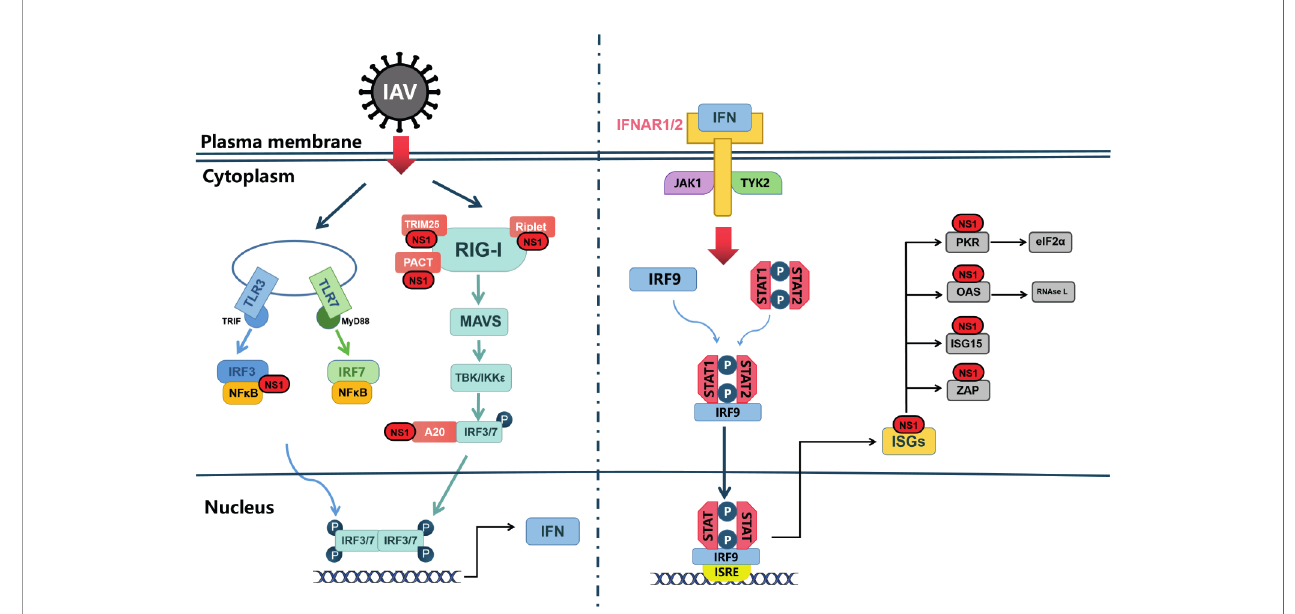
FIGURE 2 | NS1 antagonistic to web of Interferon signal. TLRs and RLRs pathways are the main pathways in the type I interferon reaction induced by in fl uenza A virus. TLR can signal through different junction proteins to trigger a signal transduction cascade leading to activation of IRF3/7 thereby inducing interferon production. Among them, TLR3 uses TRIF as a junction protein, while MyD88 is a junction protein of TLR7. RIG-I binds to viral RNA and signals down through MAVS, and activation of IRF3/7 and NF- k B factors induces synthesis of type I interferon mRNAs. IFNAR1/2, through JAK1 and TYK2, causes STAT1, STAT2 phosphorylated into dimers, which together with IRF-9 form ISGF3 that translocates to the nucleus, stimulating the expression of ISGs. In virus-infected cells, NS1 can interact with various host proteins to suppress cellular mRNAs through RIG-I receptor interactions as well as competitive binding of dsRNA. NS1 can also interact with various ISGs to antagonize the host ’ s natural immune